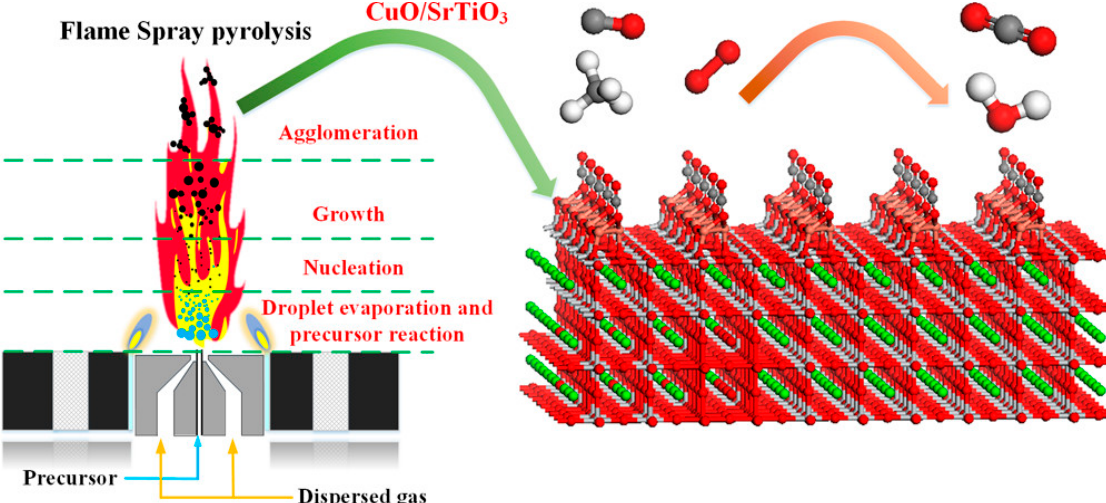
Figure 7. Reaction scheme for CuO/SrTiO 3 catalysts. Reprinted with permission from Ref. [77].